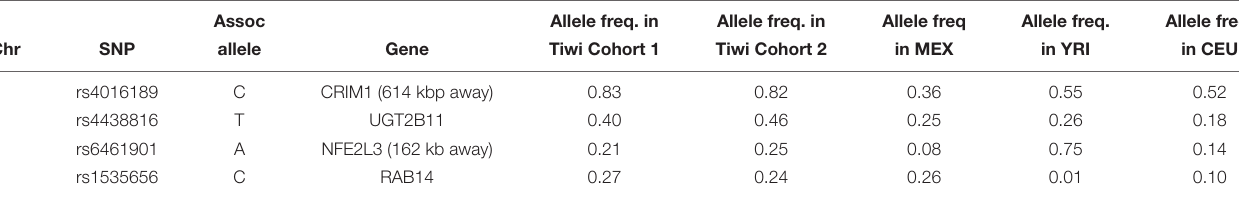
RAB14 0.26 0.01 0.10 Allele frequencies for the other populations were obtained from https://www.ncbi.nlm.nih.gov/variation/tools/1000genomes/. MEX = Mexican Ancestry in the United States, YRI = Yoruba in Ibadan, Nigeria, CEU = North and Western European Ancestry in United States.